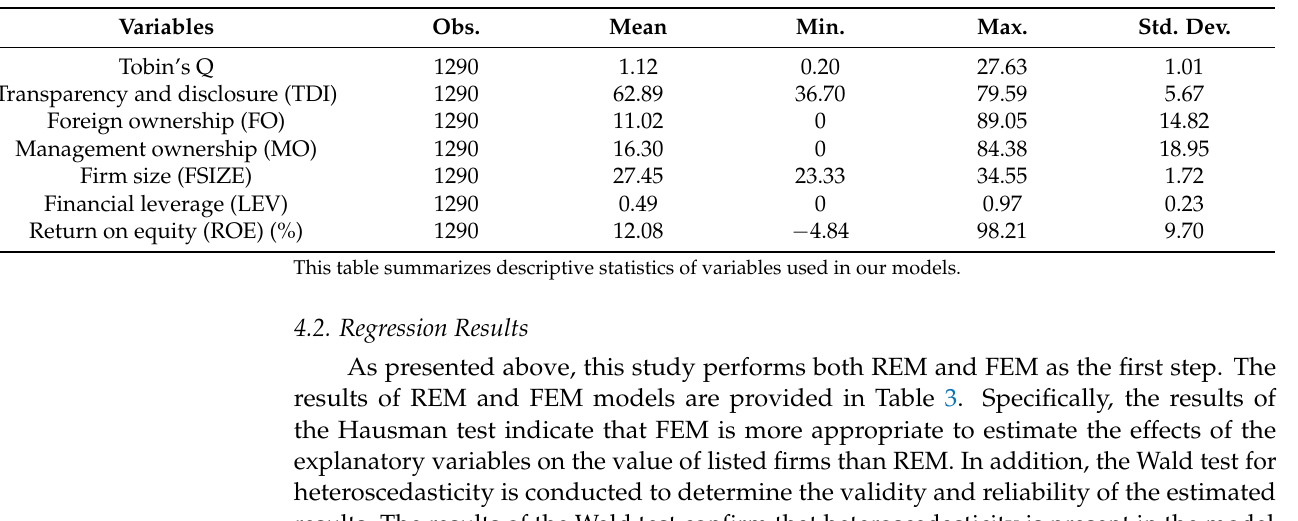
Table 2. Summary statistics of the